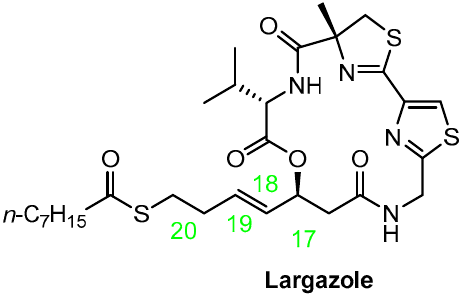
Figure 2. Chemical structure of largazole.